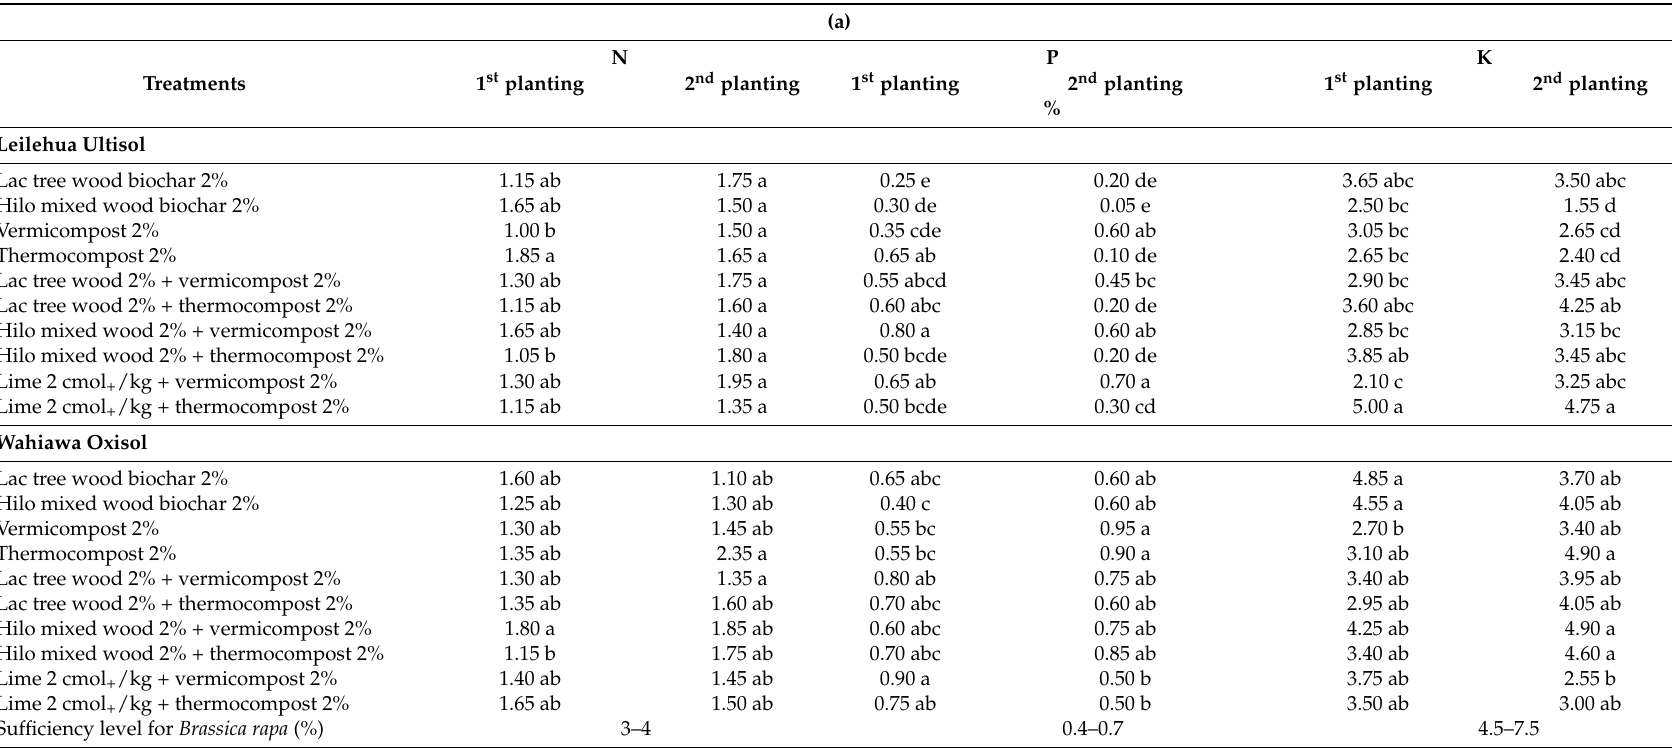
Table 6. (a). Means of N, P and K concentration in Chinese cabbage tissues as affected by biochar, lime, and/or compost additions ( n = 3). (b). Means and standard errors of Ca, Mg, Fe and Mn concentration in Chinese cabbage tissues as affected by biochar, lime, and/or compost additions ( n = 3). (a) N P Treatments